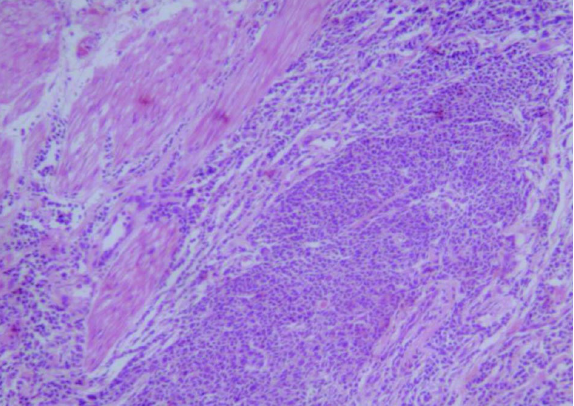
Figure 2 – Histological analysis of bladder wall showing lymphoproliferative process with follicular pattern (HE, X250).